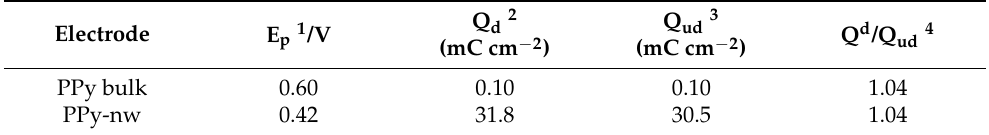
Table 1. Effect of electrode structure on p -doping process description. Electrode E p 1